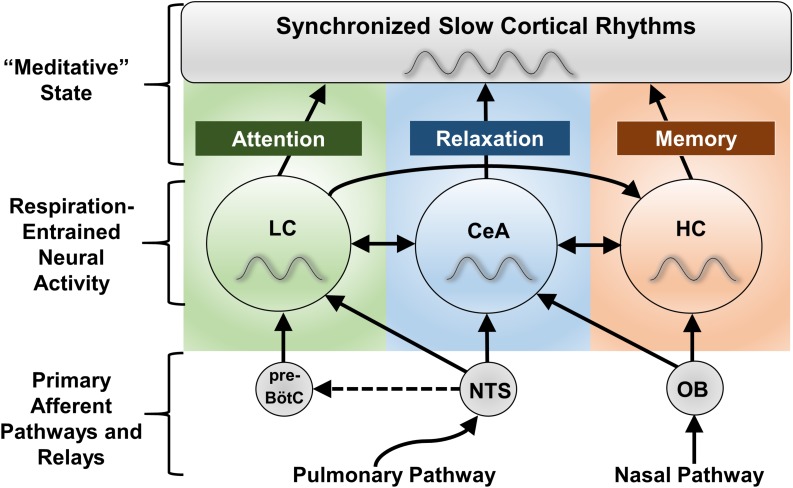
Proposed CNS regions mediating the effects of slow breathing on anxiety, attention, and memory. The locus coeruleus (LC), central nucleus of the amygdala (CeA), and hippocampus (HC) all experience fluctuations in neuronal firing entrained to the respiratory cycle (Zhang et al., 1986a; Chen et al., 1991; Guyenet et al., 1993; Oyamada et al., 1998; Zelano et al., 2016). Despite impacting a broad array of functions, these regions are known to specialize in the regulation of anxiety state (CeA), attention and arousal (LC), and memory (HC), and together project to nearly the entire forebrain. In the forebrain, local processes converge into global respiratory rhythmic slow waves that may serve as the substratum for altered states of consciousness, including those subjectively experienced during meditation techniques involving slow, deep breathing. Interactions between LC, CeA, and HC pathways are proposed to complexly define cognitive and behavioral state. NTS stimulation may also activate the paraventricular nucleus of the hypothalamus (PVN, not shown) through the CeA to regulate the release of cortisol (Ressler, 2010), although this may be an indirect effect (no significant change in hypothalamic activity was observed with stimulation of Hoxb1 noradrenergic neurons, Chen et al., 2018). Dashed lines indicate hypothetical connections. NTS, nucleus of the solitary tract; OB, olfactory bulb; pre-BötC, pre-Bötzinger complex.